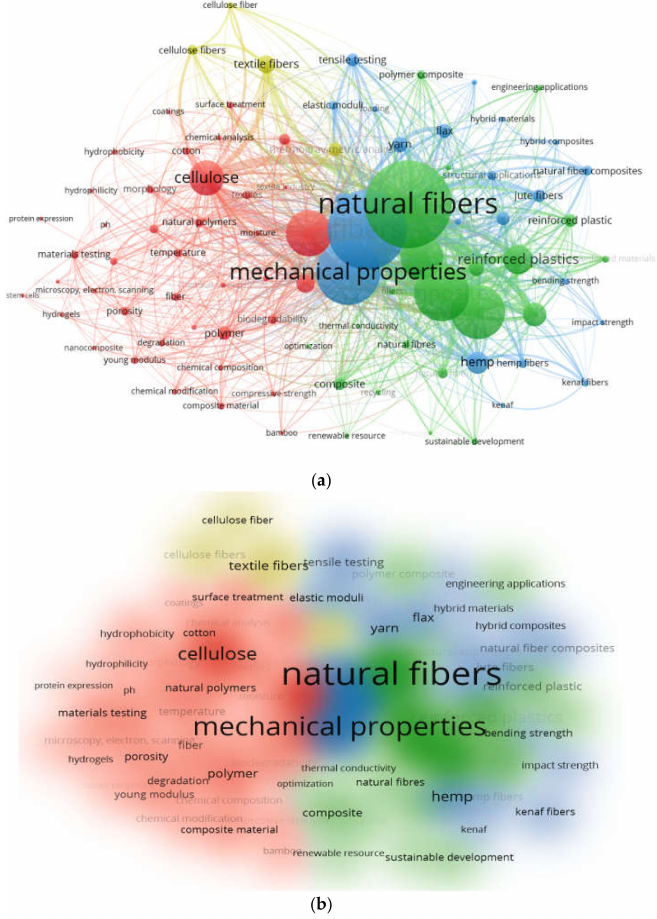
Figure 5. Network based on all keywords: ( a ) occurrence during the last 5 years; ( b ) density showing the recent focus on sustainable